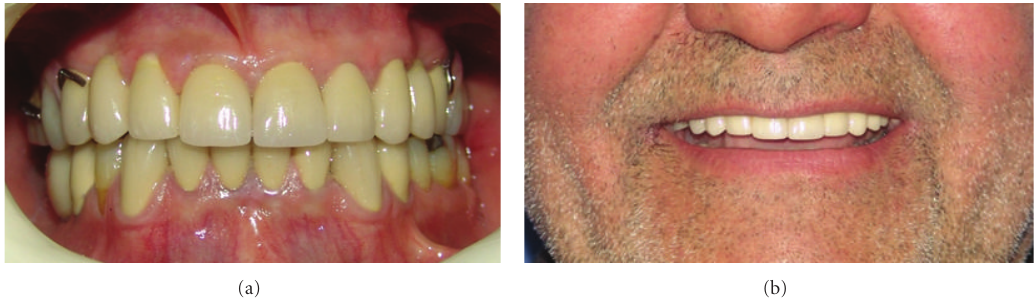
Figure 6: Frontal view of teeth in occlusion after treatment (a); smile view after treatment (b).